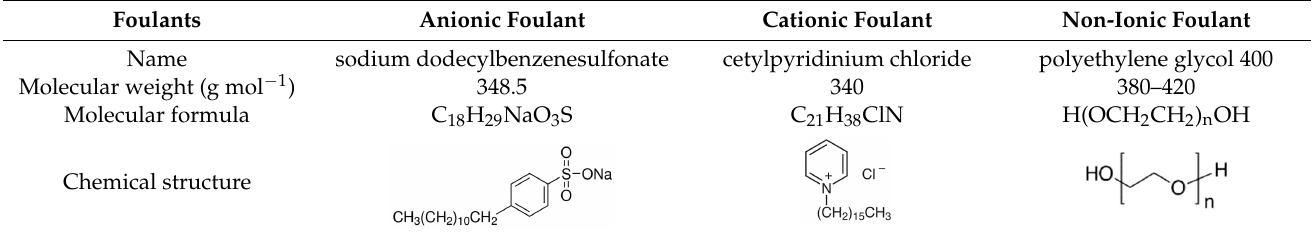
Table 2. Summary of surfactants as foulants used in this study.